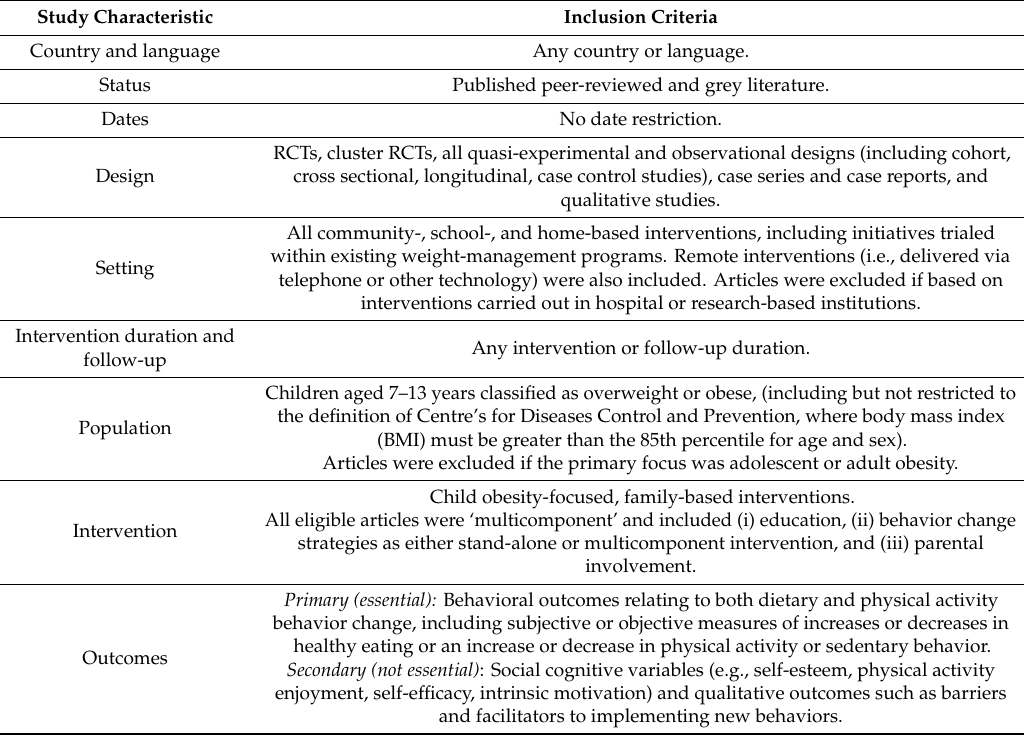
Table 1. Inclusion and exclusion